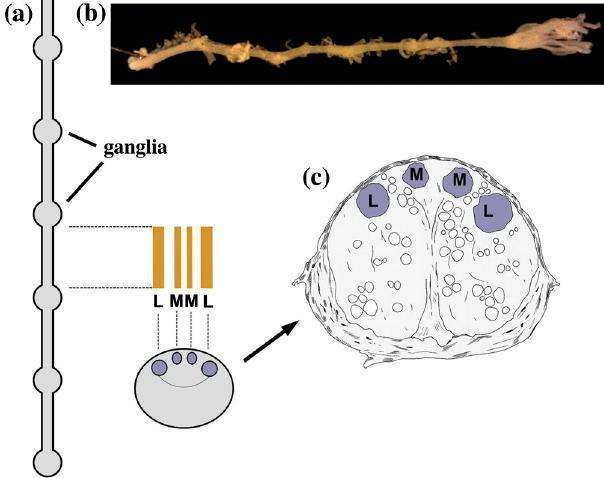
FIG. 3. (a) Schematic representation of a lobster ventral cord at the abdominal (tail) site with six ganglia, (b) abdominal ventral cord extracted from the lobster tail, and (c) internal structure of the ventral cord showing four giant axons.